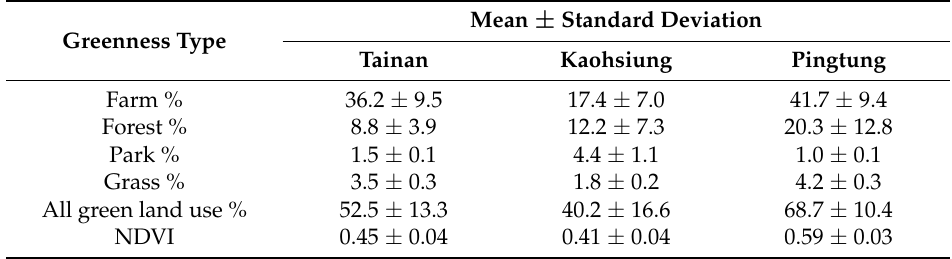
Table 1. The Descriptive Statistics of Different Types of Surrounding Greenness in Southern Taiwan.